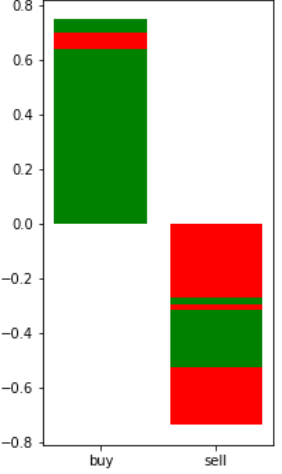
Figure 8. IndusInd stock Buy and Sell